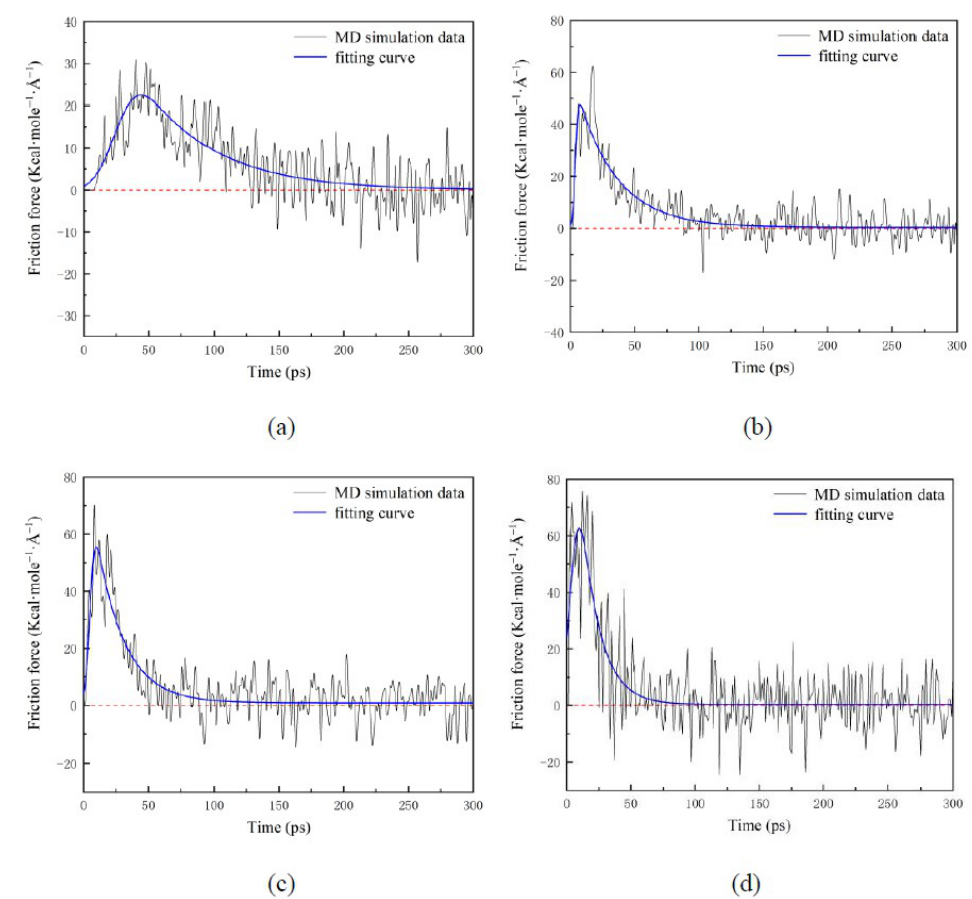
Figure 10. Time evolution of the friction force applied to water nanodroplets with various We : ( a ) We = 0.82; ( b ) We = 20.58; ( c ) We = 40.33; ( d ) We = 66.67.